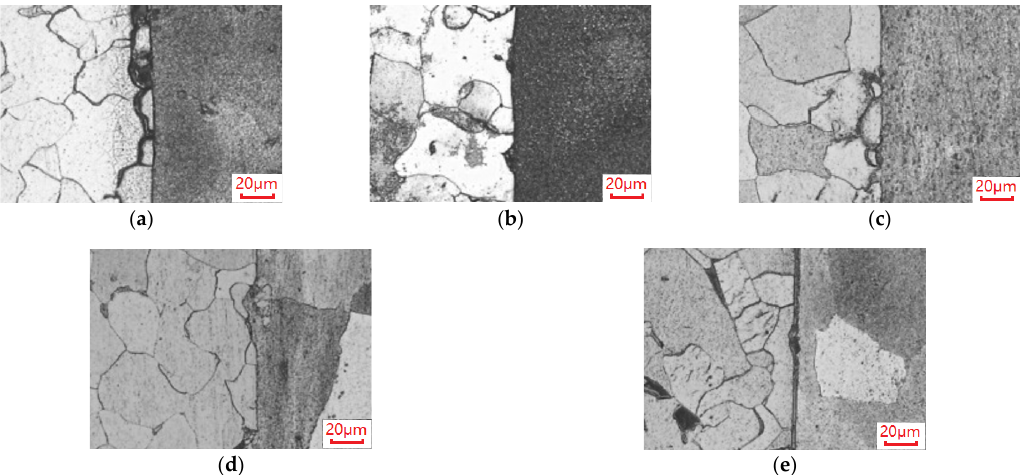
Figure 3. Microstructures of copper/steel interface at different casting temperatures. ( a ) 1100 °C; ( b ) 1125 °C; ( c ) 1150 °C; ( d ) 1175 °C; and ( e ) 1200 °C.